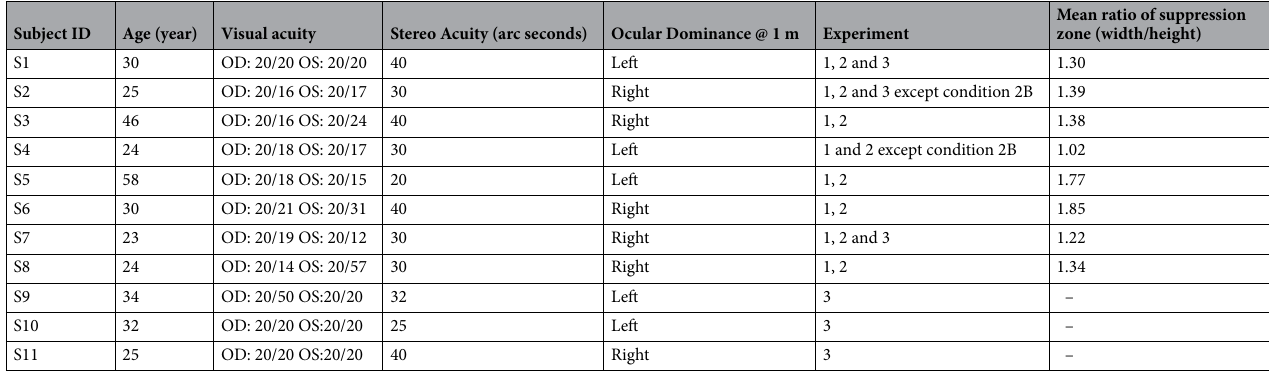
Table 1. Clinical data for each subject. The mean ratio of suppression zone width to its height for each subject in Experiment 2 is listed in the last